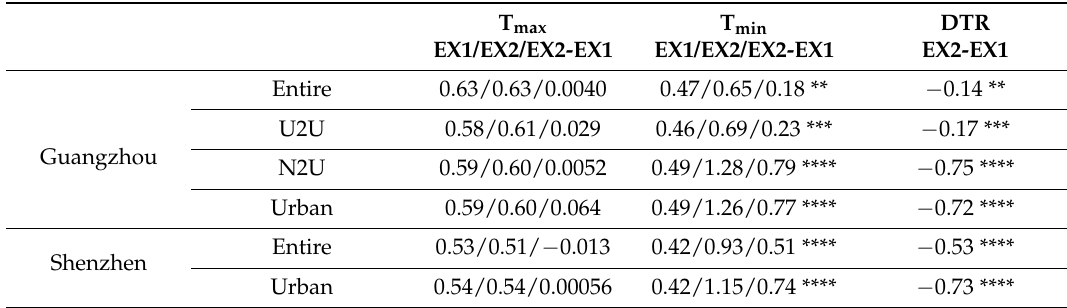
Table 4. The changing trends of T max and T min for EX1 and EX2, and the corresponding differences for T max , T min , and DTR over the subregions of Guangzhou/Shenzhen (the entire, U2U, N2U, and urban